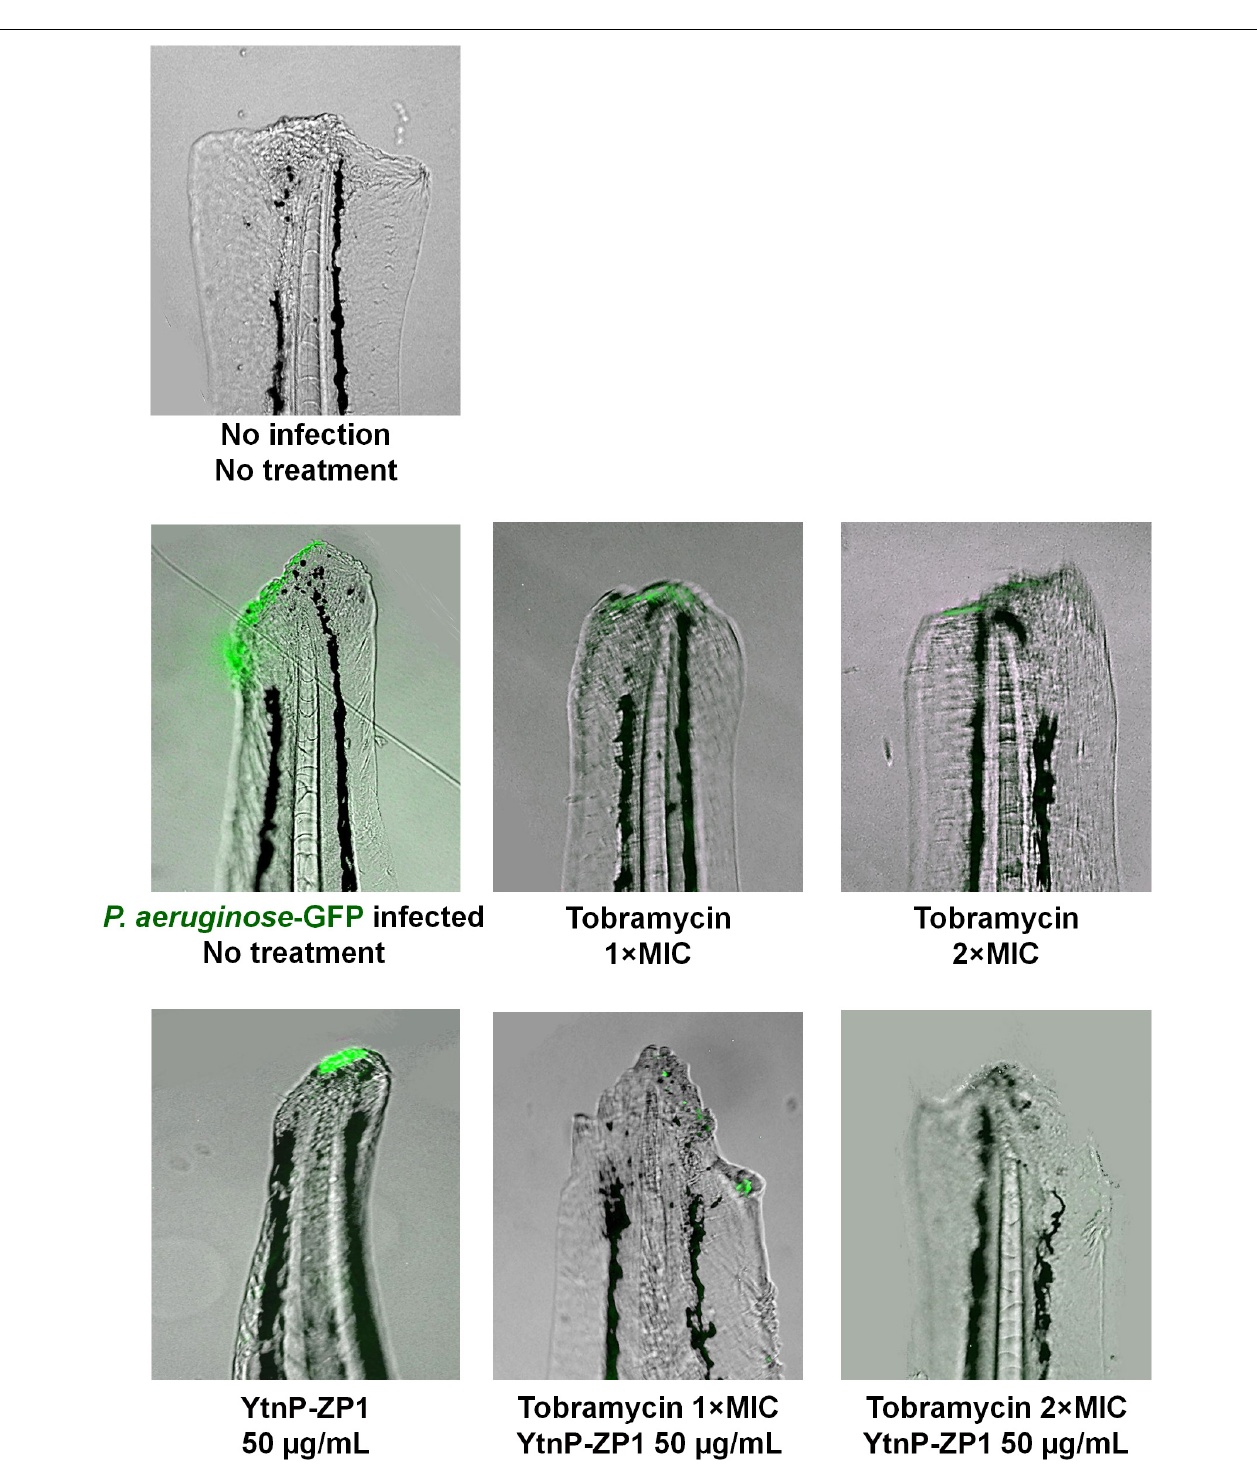
FIGURE 9 | Pseudomonas aeruginosa PAO1 tail wound infection was successfully eliminated by applying YtnP-ZP1 in combination with tobramycin. Wild-type zebrafish embryos were decapitated at 72 hpf and infected with 4–6 × 10 7 cells of P. aeruginosa PAO1-GFP. After 1–2 h of recovery, wounded embryos were treated with tobramycin, lactonase, or their combination. Individual treatment with enzyme or antibiotic partially eliminated infection from the wounded tail, while combination treatment with lactonase and tobramycin was more effective resulting in no visible bacterial infection (lack of fluorescence).